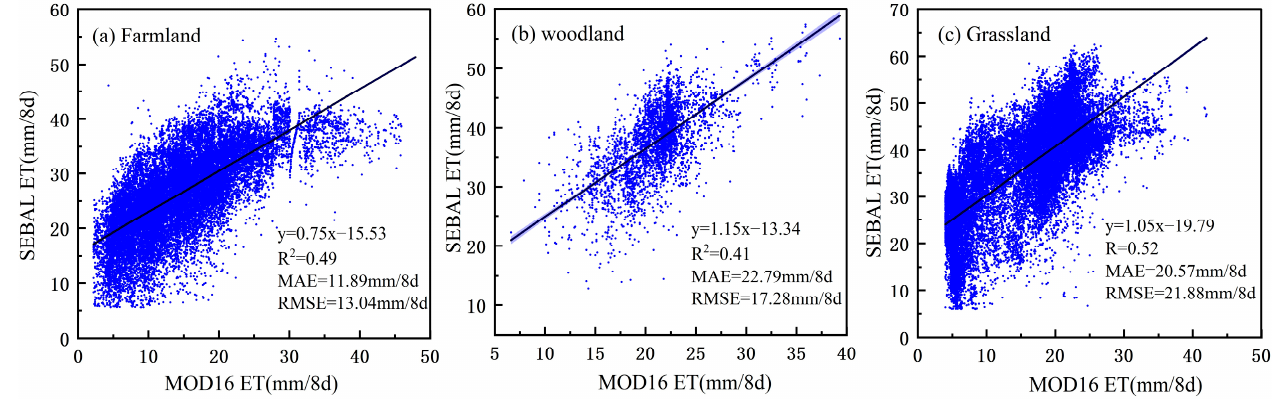
Figure 4. Comparison of SEBAL ET and MOD16 ET for di ff erent LULC types in DOY 193–DOY 200 in 2020. ( a ) Farmland; ( b ) woodland; and ( c ) grassland.